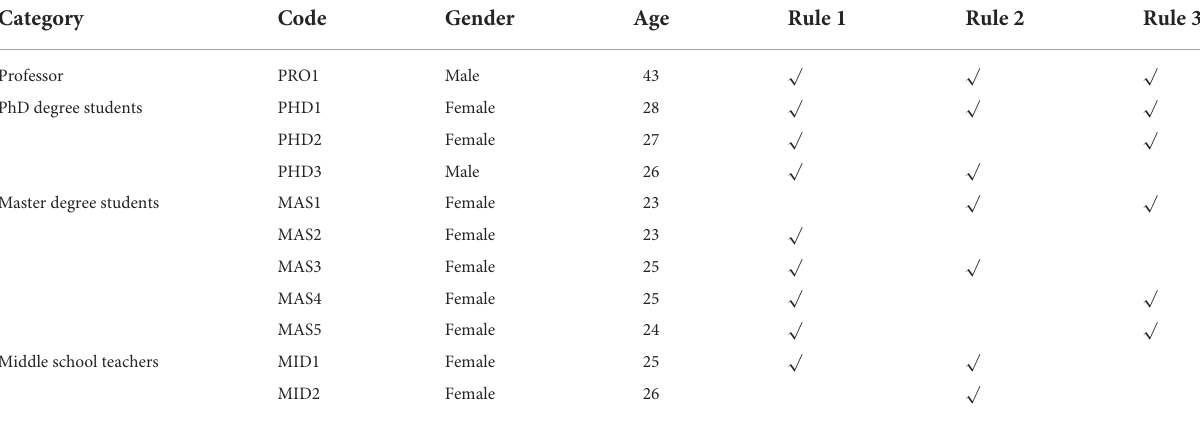
TABLE 1 Demographic statistics of the participants in TDL-TPACK construction.